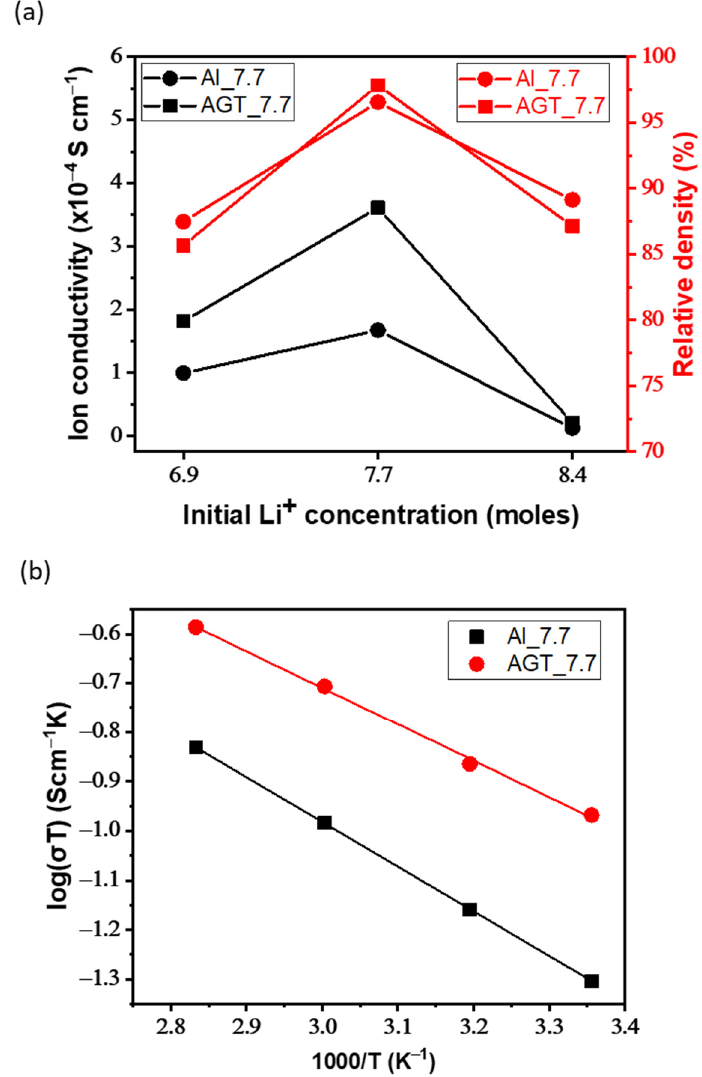
Figure 7. ( a ) Total ionic conductivity and relative density of pellets with different initial Li + concen- trations (6.6, 7.7, and 8.4 mol) at 25 °C. ( b ) Arrhenius plots of Al_7.7 and AGT_7.7 samples. Table 2. Summary of total (bulk + grain-boundary) ionic conductivity at 25 °C and relative density of pellets.